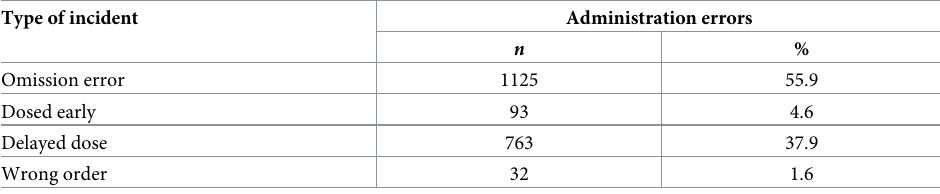
Table 3. Types of Parkinson’s medication errors that occurred during the administration phase for people with Parkinson’s disease during